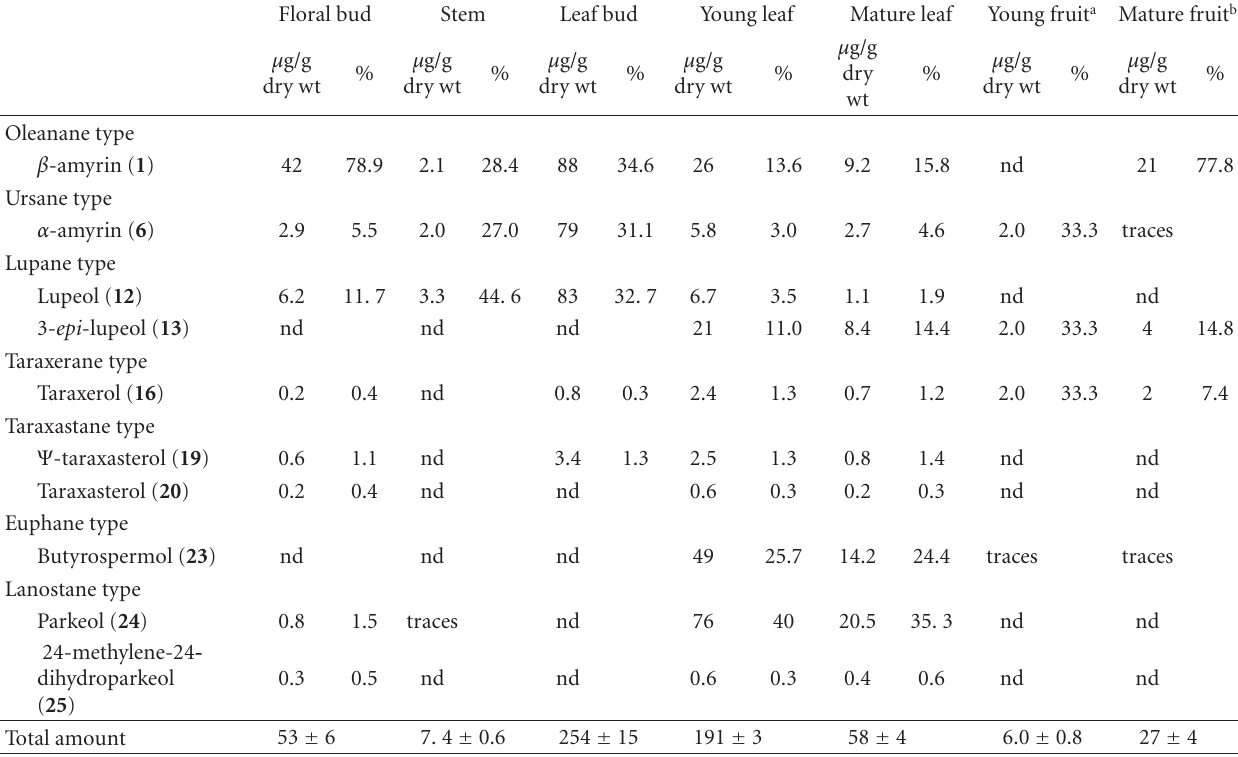
Table 4: Amounts of esterified triterpene alcohols in various organs from Olea europaea tree. Floral bud Stem Leaf